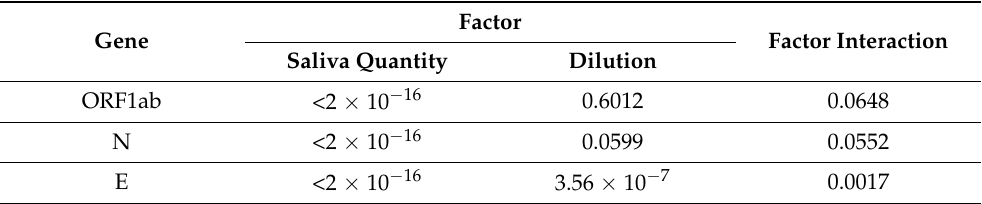
Table 1. p -values for two-way ANOVA for three target genes with two factors (saliva quantity and dilution factor) and factor interactions.